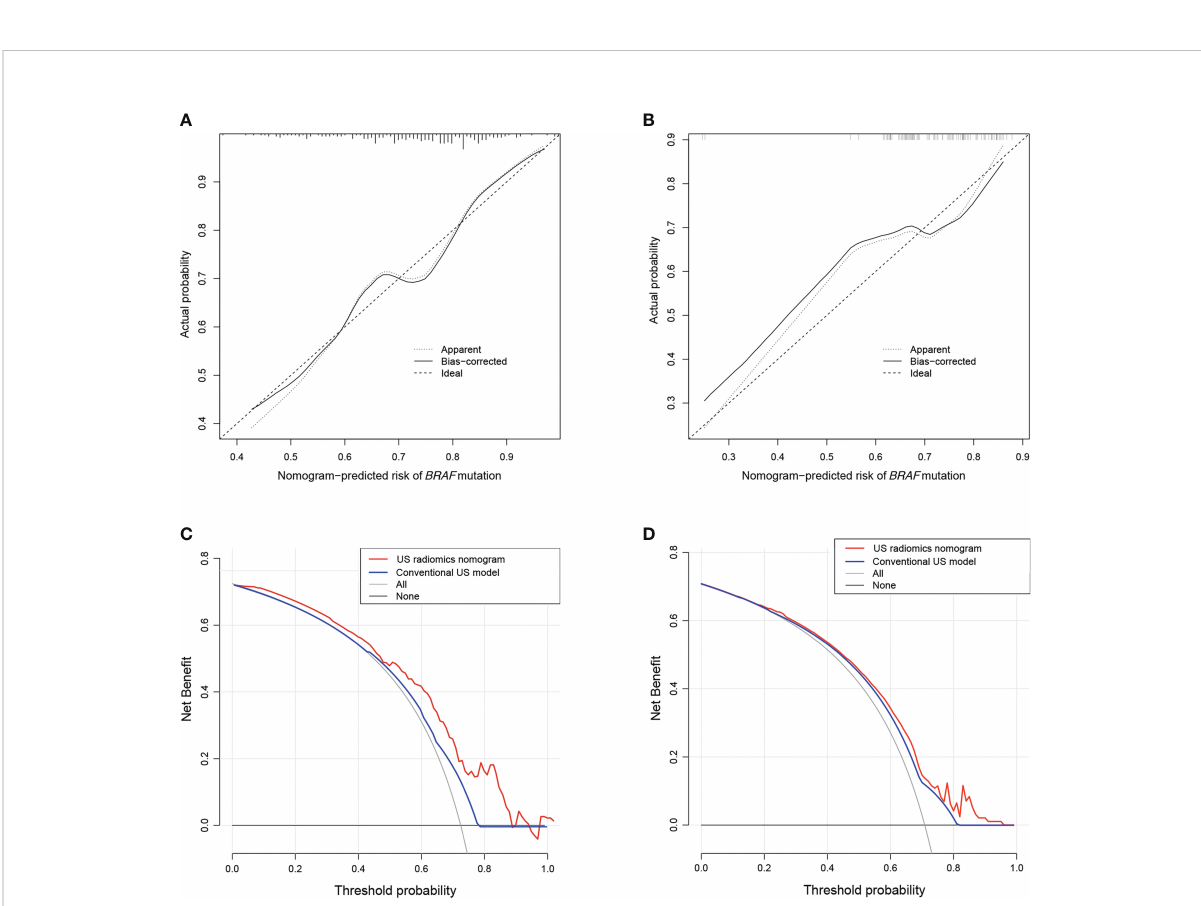
FIGURE 4 The calibration plots of the US radiomics nomogram for the training (A) and the validation cohorts (B) . Decision curve analysis of the US radiomics nomogram and conventional US model in the training (C) and validation sets (D) . US,